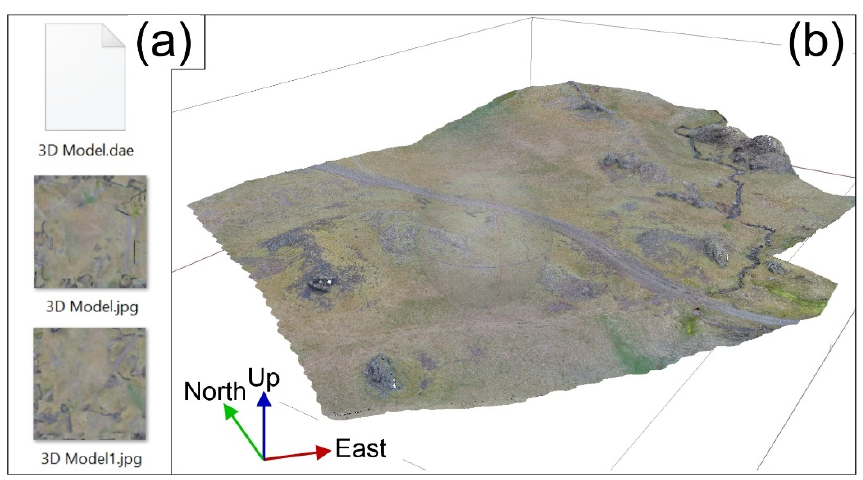
Figure 6. ( a ) Output regarding the 3D model: DAE file for the mesh and the two JPG files of the texture feature. ( b ) Final version of the 3D model.